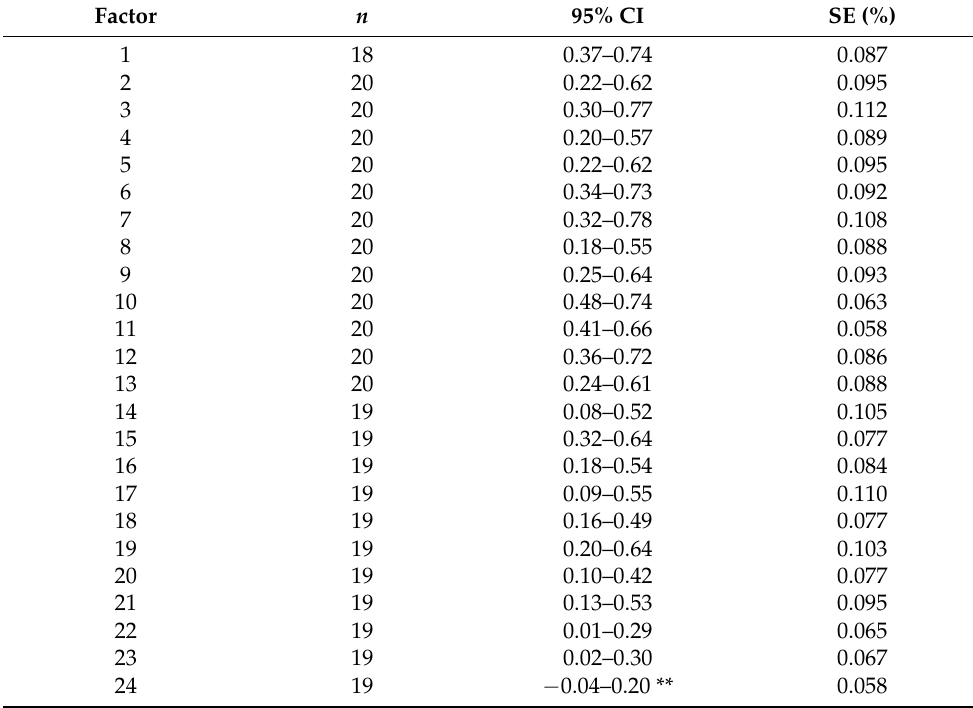
Table 4. 95% Confidence Interval (CI) and Standard Error (SE) for all